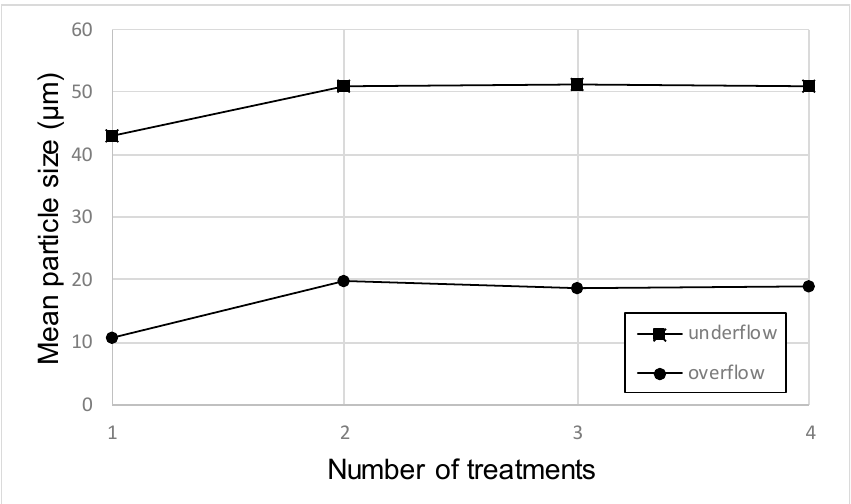
Figure 3. Variation of mean particle size with treatments.